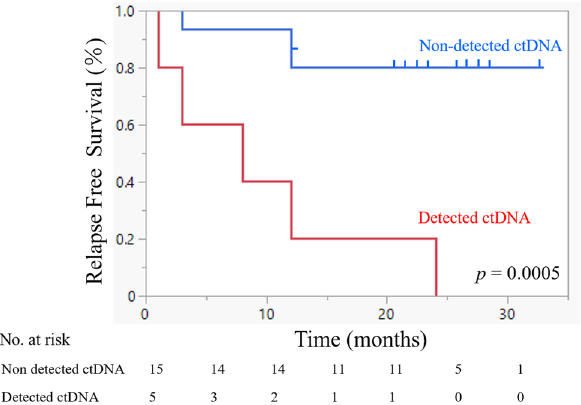
Figure 1. Relevance of ctDNA detection in relapse-free survival. Relapse-free survival (RFS) rate of 20 patients with head and neck squamous cell carcinoma who underwent detection of circulating tumor DNA (ctDNA) in